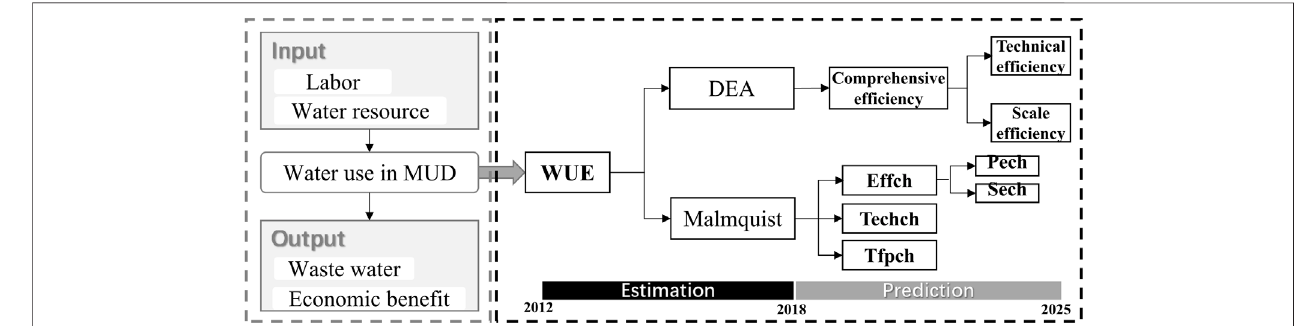
FIGURE 2 | The fl owchart of this